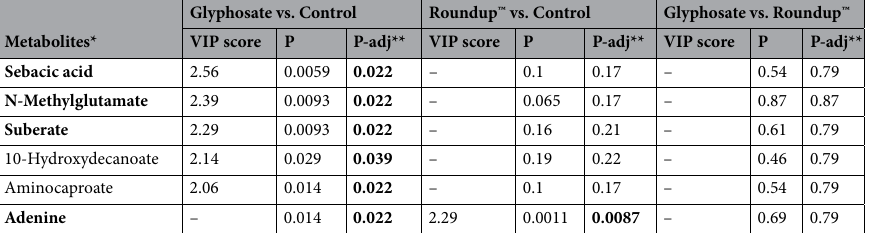
Glyphosate vs. Control